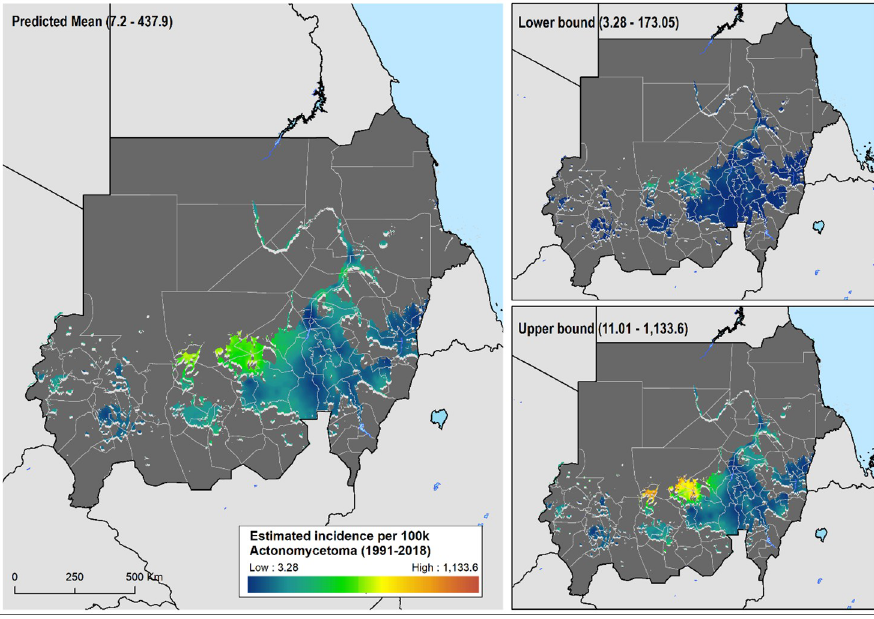
Fig 3. Estimated actinomycetoma cases per 100,000 inhabitants between 1991 and 2018; mean predicted number of cases and, lower and upper 95% CI bounds. Areas considered environmentally unsuitable for the occurrence of actinomycetoma as predicted by environmental model have been